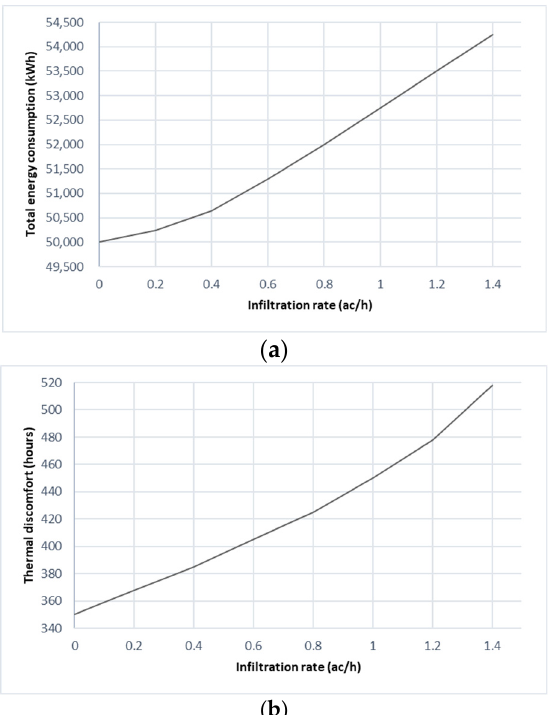
Figure 13. The effect of infiltration rate on ( a ) energy consumption and ( b ) students’ thermal discomfort hours.